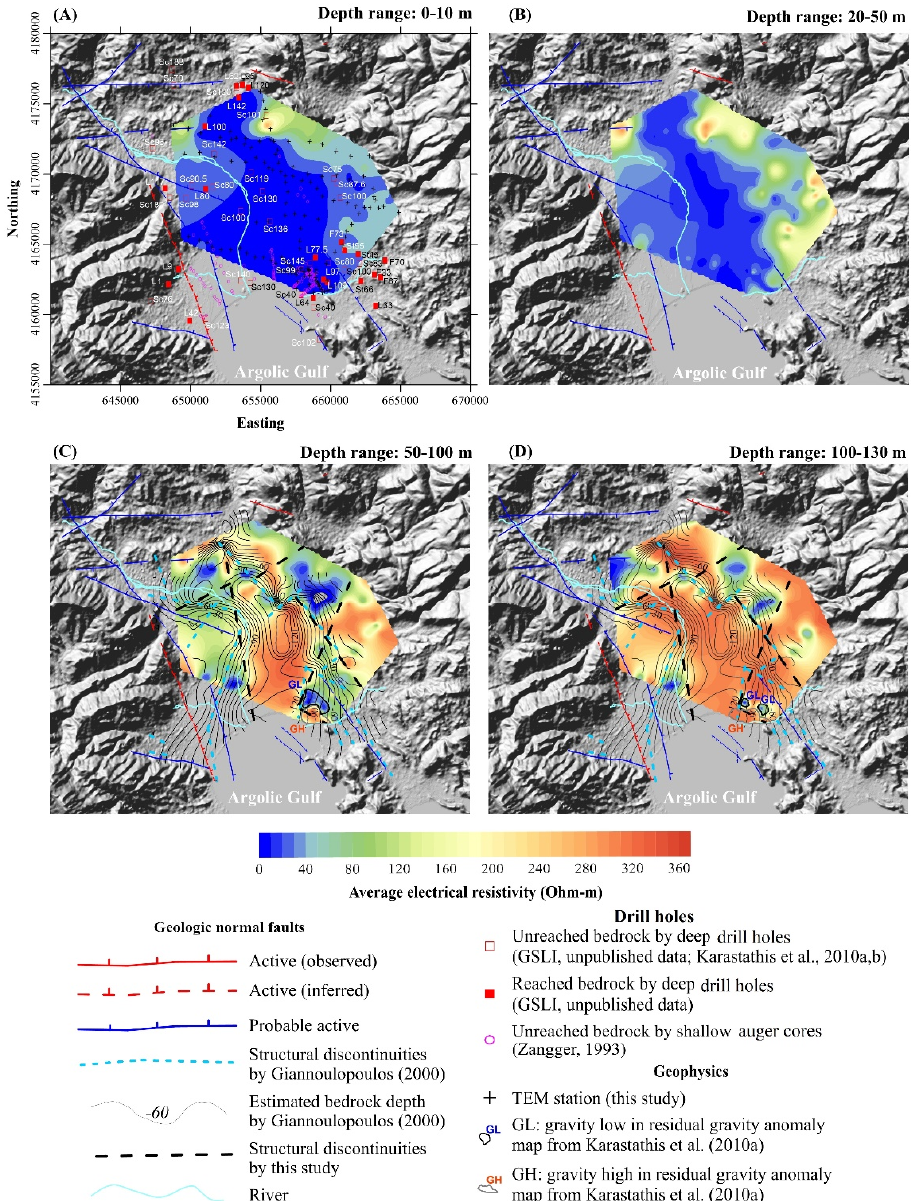
Figure 8. Depth slices of average electrical resistivity ( A – D ) for the Argive Basin derived from the TEM deployment. The depth slices are plotted over the digital terrain model and known normal faults and structural features. Depth slices in ( A – D ) are for 0–10 m, 20–50 m, 50–100 m, and 100–130 m, respectively. For simplicity, only ( A ) shows the distribution of the TEM sounding stations and the vintage stratigraphic logs (drill holes). Both the depth to bedrock and interpreted structural discontinuities from Giannoulopoulos [36], plotted in ( C , D ), agree with the TEM results, the gravity results from Karastathis et al. [23], and the well-known structural geologic conditions (Europe UTM Zone 34N coordinate system).